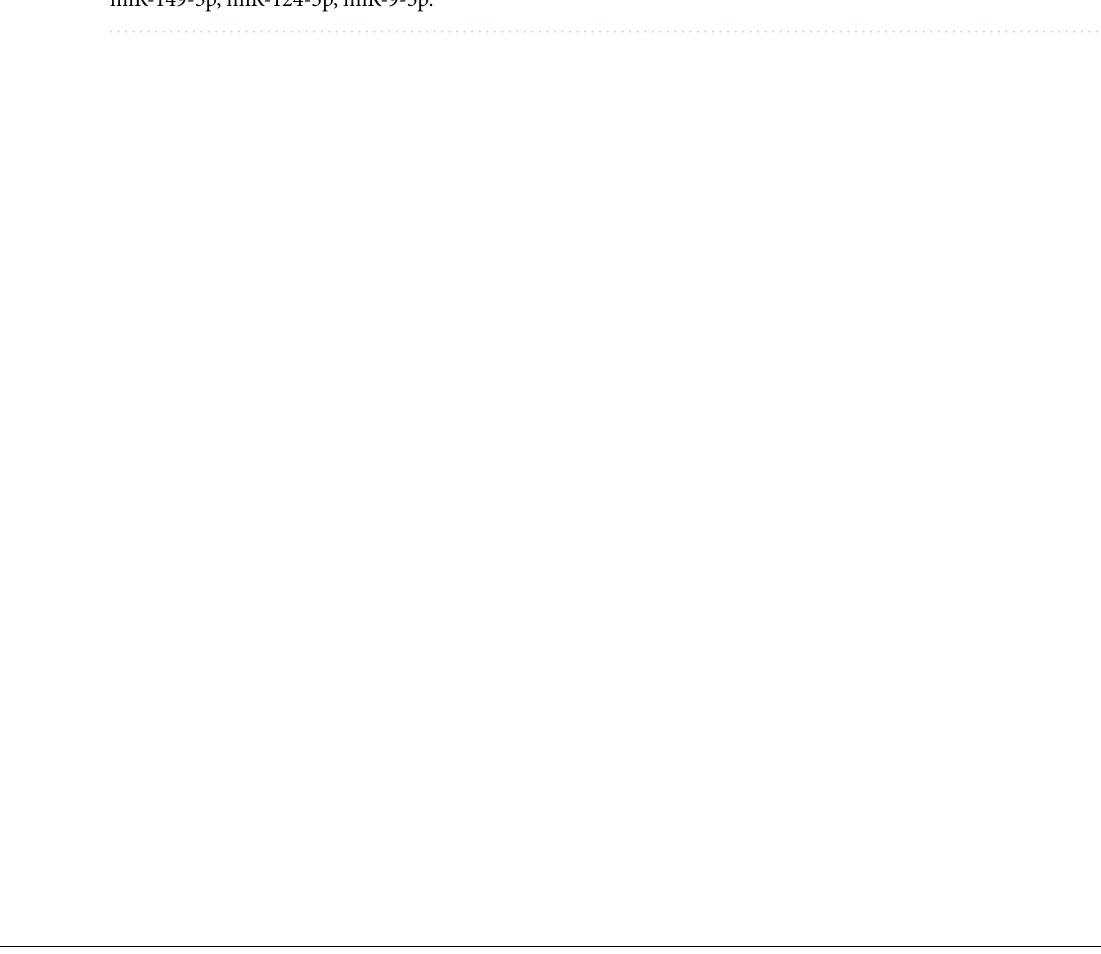
Figure 6. Graph of the network between the hub genes and miRNAs. ( A ) TLR5 may be negatively regulated by miR-20a, miR-101-3p, and let-7f. ( B ) miR-20a may negatively regulate FCGR1A. ( C ) Negative regulatory relationship between ELANE and miR-196b-3p. ( D ) GNLY may be negatively regulated via miR-129-5p, miR- 149-5p. ( E ) miR-212-5p may negatively regulate IL2RB. ( F ) TGFBR3 may be negatively regulated by miR-219a, miR-149-5p, miR-124-3p,